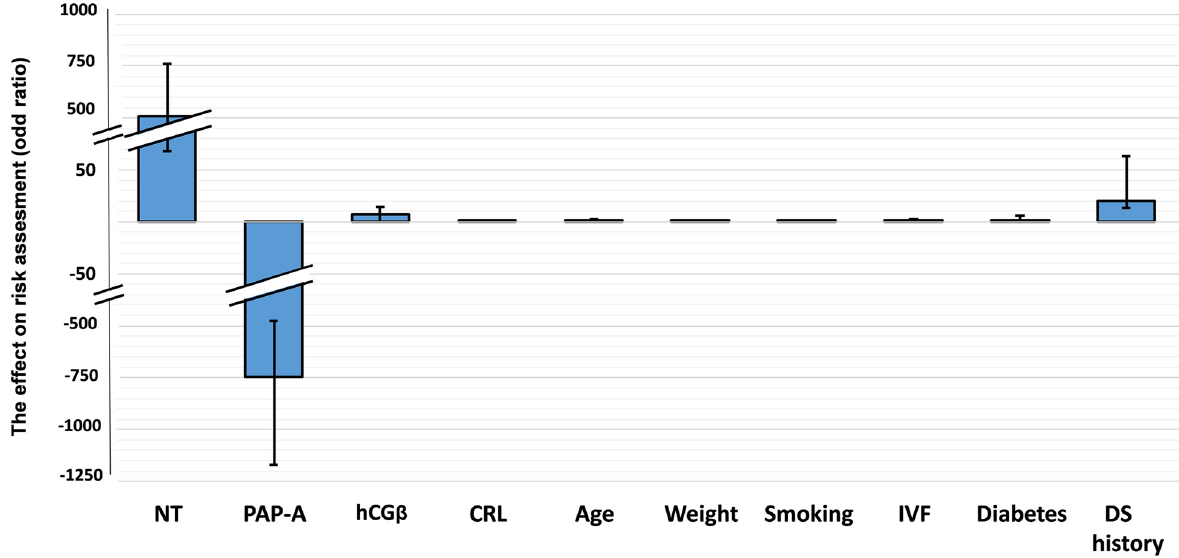
Figure 1: The odd ratios of all parameters of first trimester Down syndrom risk